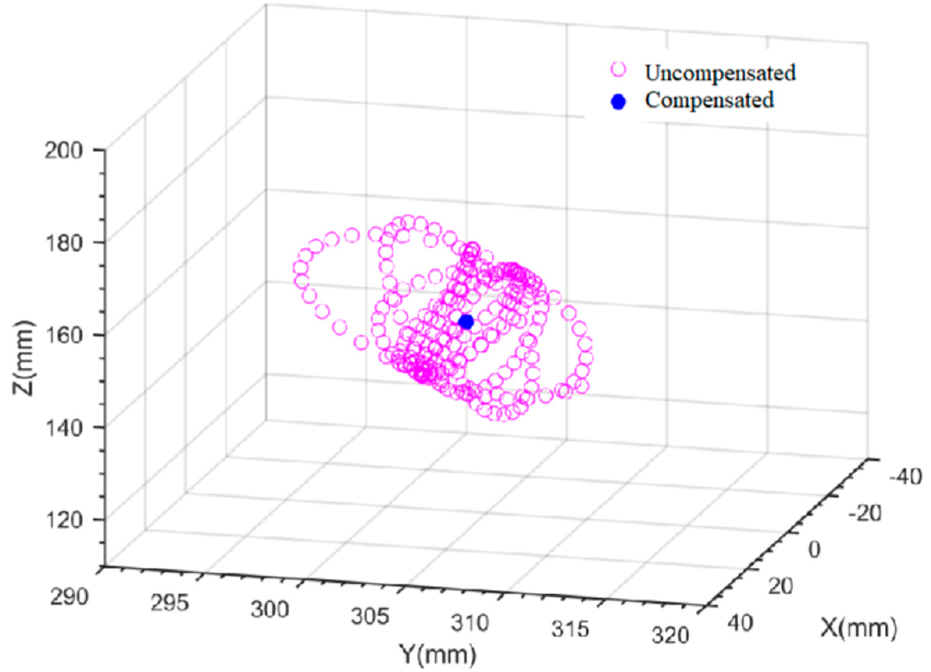
Figure 22. Comparison between uncompensated and compensated end effector trajectories when the ship is equipped with a passive anti-rolling tank.